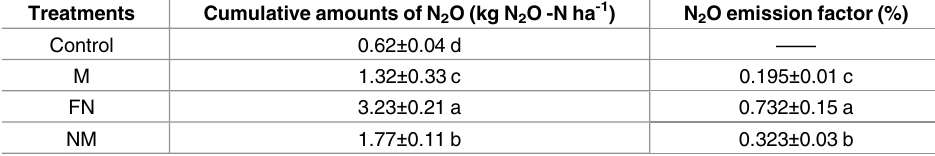
Data are means ± standard error (n = 3). Different letters within the same column indicate significant differences among treatments at P < 0.05.